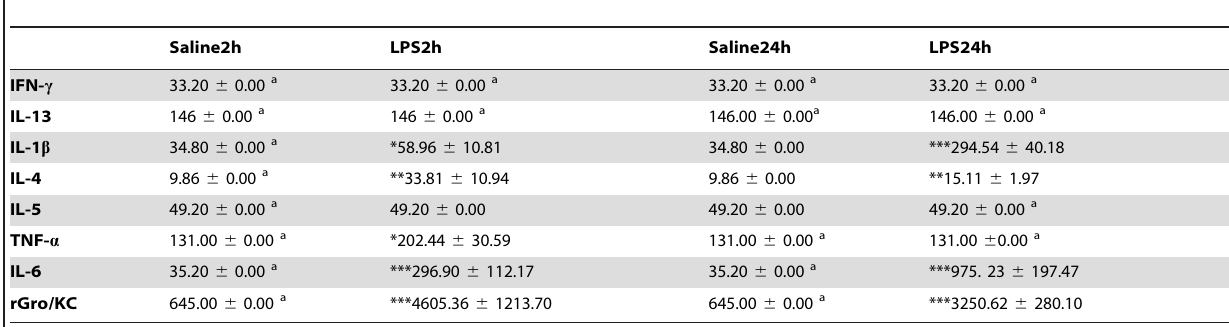
Table 2. CSF cytokine levels (pg/ml) 2 h and 24 h after LPS and saline treatment.